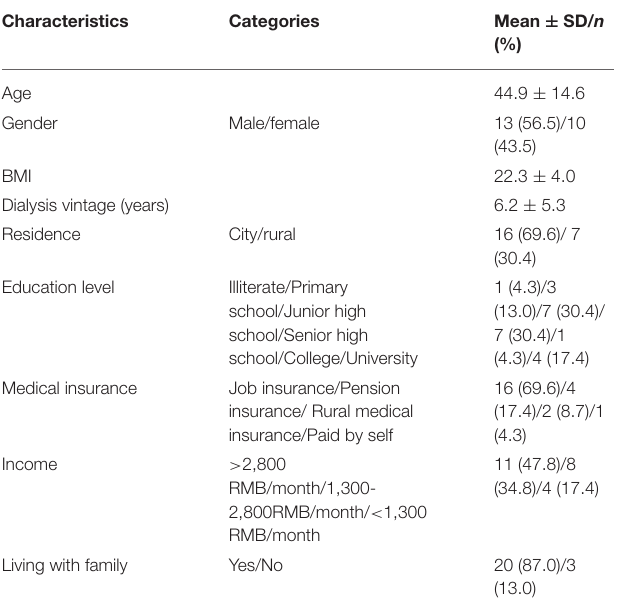
TABLE 1 | Demographics of participants ( n =